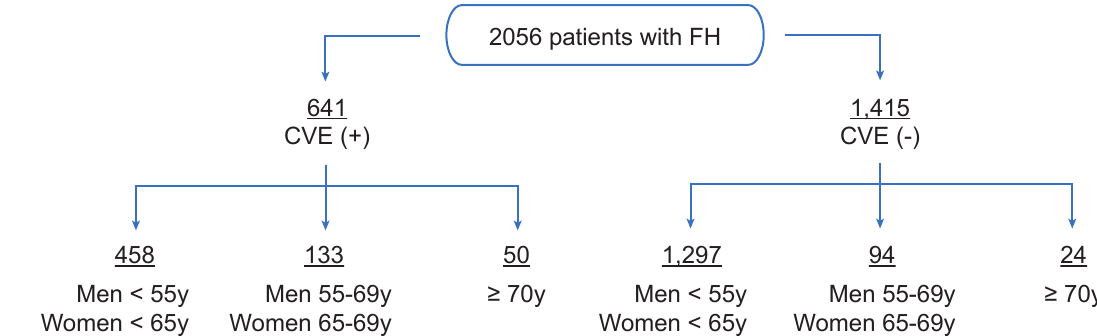
Figure 1. Study design. Representation of the initial sample ( n = 2056) of French–Canadian subjects with FH, among them 1116 subjects whose FH status was confirmed by Simon Broome criteria and 940 definite FH adults known to carry FH-causing mutations in the LDLR gene. The study sample was stratified according to age and occurrence of cardiovascular events (CVE) requiring medical intervention (myocardial infarction, unstable angina, coronary artery bypass grafting, percutaneous transluminal coronary